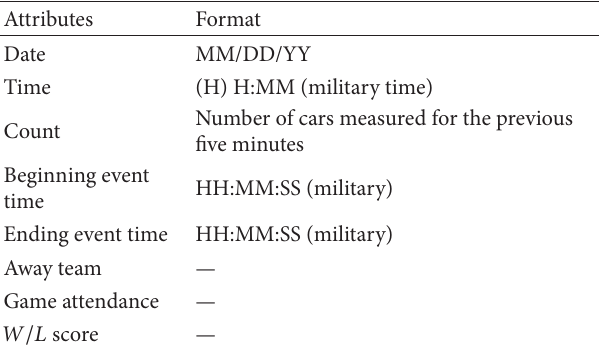
Table 1: Constraints